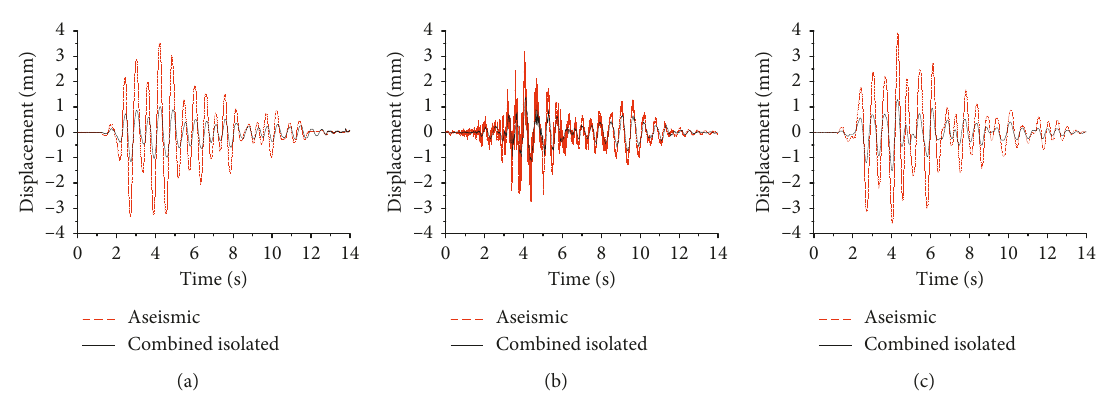
Figure 5: X -axis relative displacement time history curves of the top floor of the third subframe. (a) Chi-Chi-2N, (b) Chi-Chi-2F, and (c)